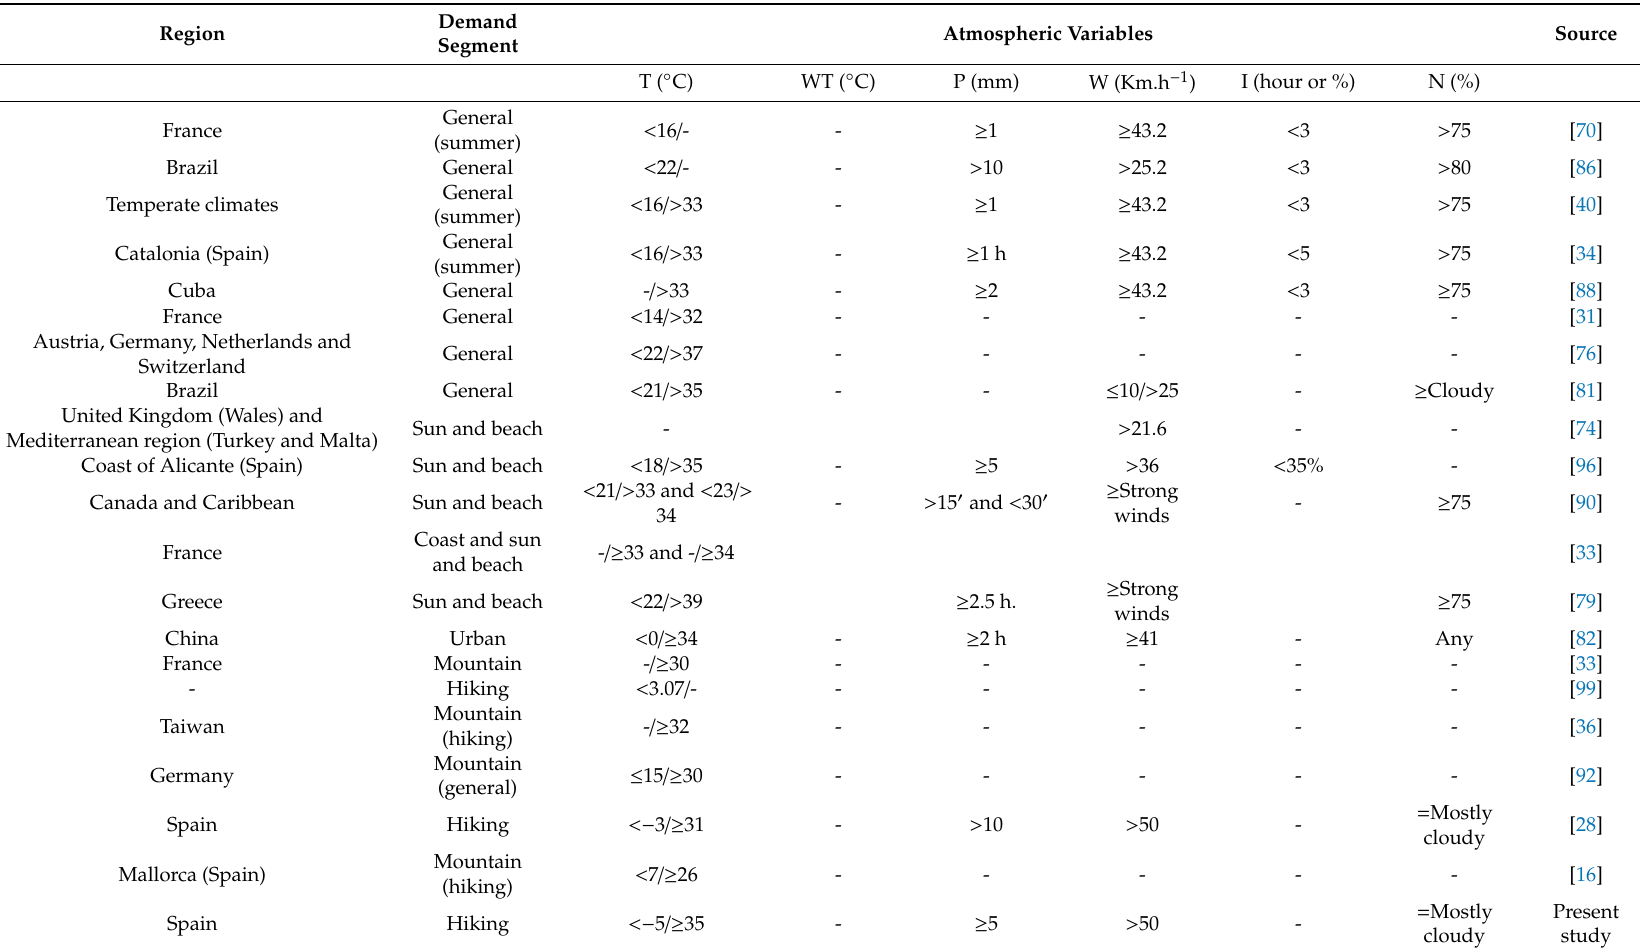
Table 4. Unfavourable weather conditions for di ff erent kinds of tourism activities at a daily